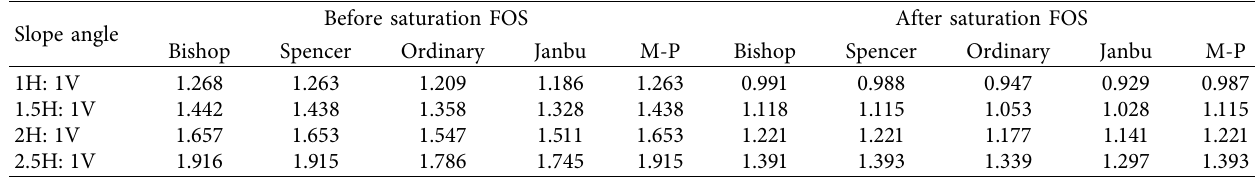
Table 10: FOS values for slope-3 for different slope angles before and after saturation.